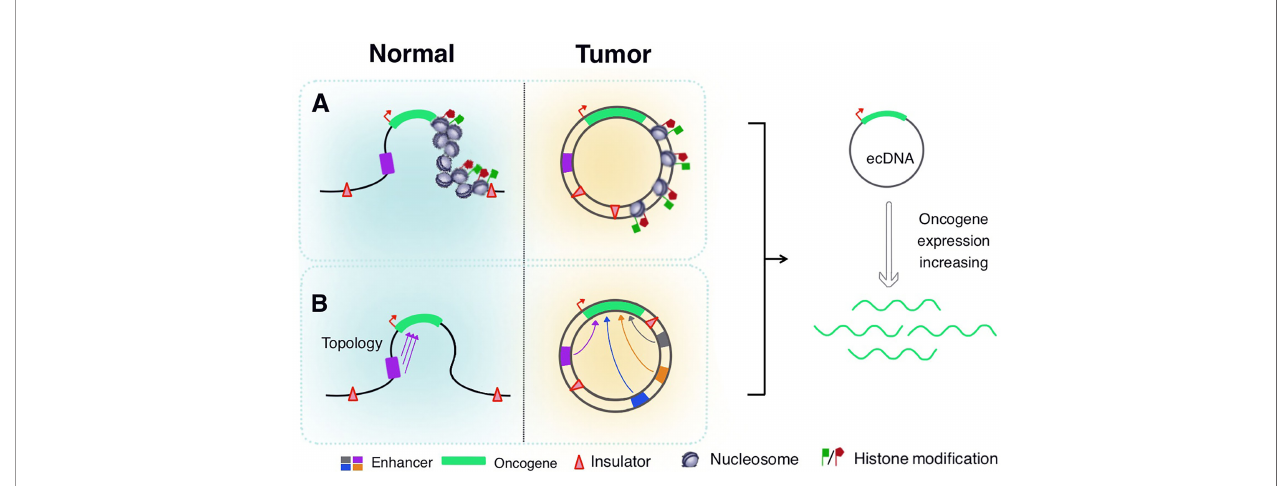
FIGURE 3 | Regulation of eccDNA expression. (A) EccDNA is packaged into chromatin structures with complete domains, but lacks the typical higher-order chromosome compression, revealing signi fi cantly enhanced chromatin accessibility and histone modi fi cations. (B) EccDNA chromatin forms a three-dimensional structure with topologically related domains, so that distant DNA elements become closer to achieve ultra-long-distance interactions. The oncogenes in eccDNA signi fi cantly enhance their self-regulatory activity through advanced ampli fi cation and circularization with adjacent